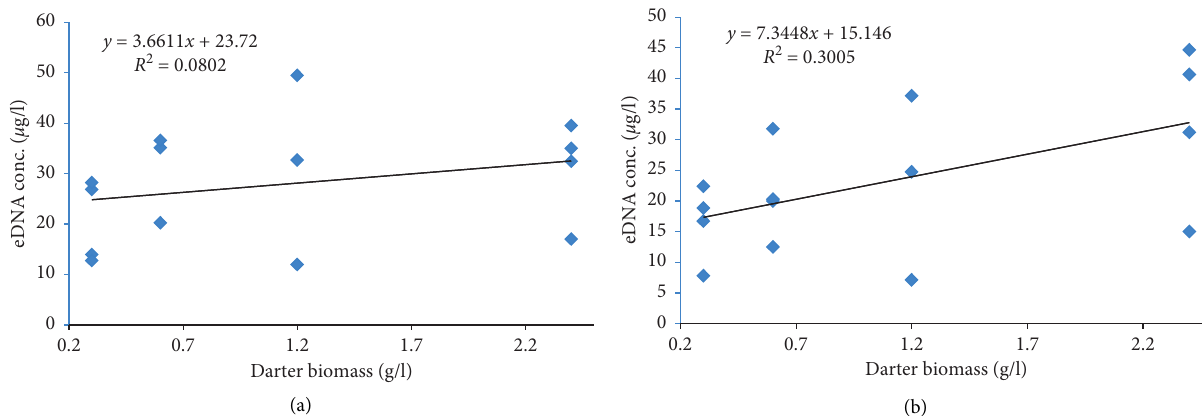
Figure 1: eDNA concentrations at various biomass levels for single filter method ( p � 0 . 326) (a) and multiple filter method ( p � 0 . 034)